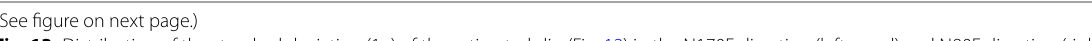
strain and tilt data respectively. The optimal hyper- parameters are listed in Table 1. Estimated slip distri- bution, distribution of the standard deviation of the slip in the two orthogonal directions at each subfault, and the comparison between observed strain and tilt data and calculated strain and tilt data are shown in